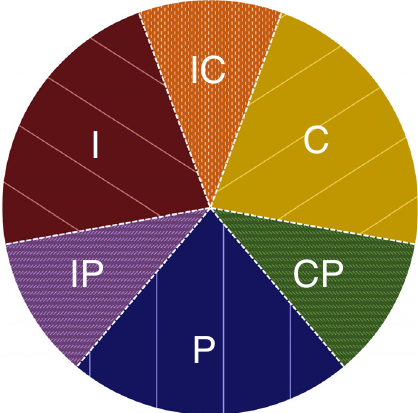
FIG. 4. A revised modal taxonomy that incorporates the observation and existence of mixed-modal pedagogy. Solo modes are patterned with solid stripes, while mixed modes are patterned with dashes. The dotted white lines between modes represent the permeability of modes in this model compared to the 2016 model shown in Fig.